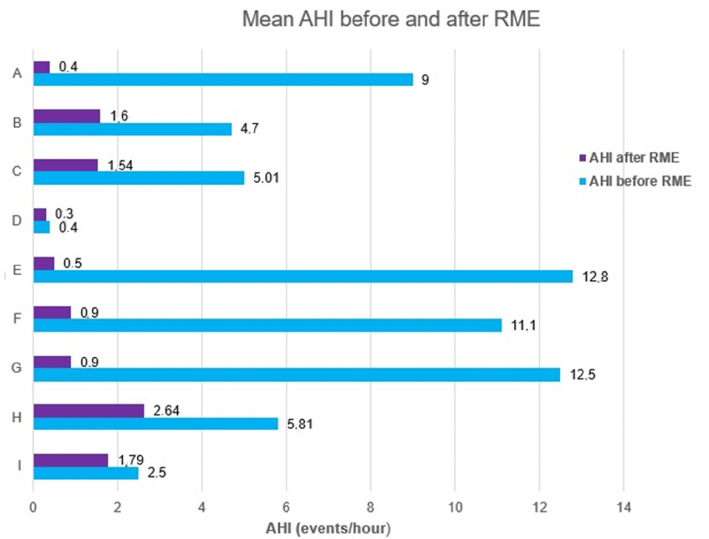
Figure 2. Reported effects on the Apnea Hypopnea Index (AHI) index after Rapid Maxillary Ex- pansion (RME) application. A: Guilleminault C. et al 2013 [3]. B: Villa M.P. et al 2015 [64]. C: Fastuca R. et al [56]. D: Pirelli P. et al 2015 [65]. E: Pirelli P. et al 2005 [13]. F,G: Guilleminault C. et al 2011 [5]. H: Villa M.P. et al 2013 [4]. I: Hoxa S et al